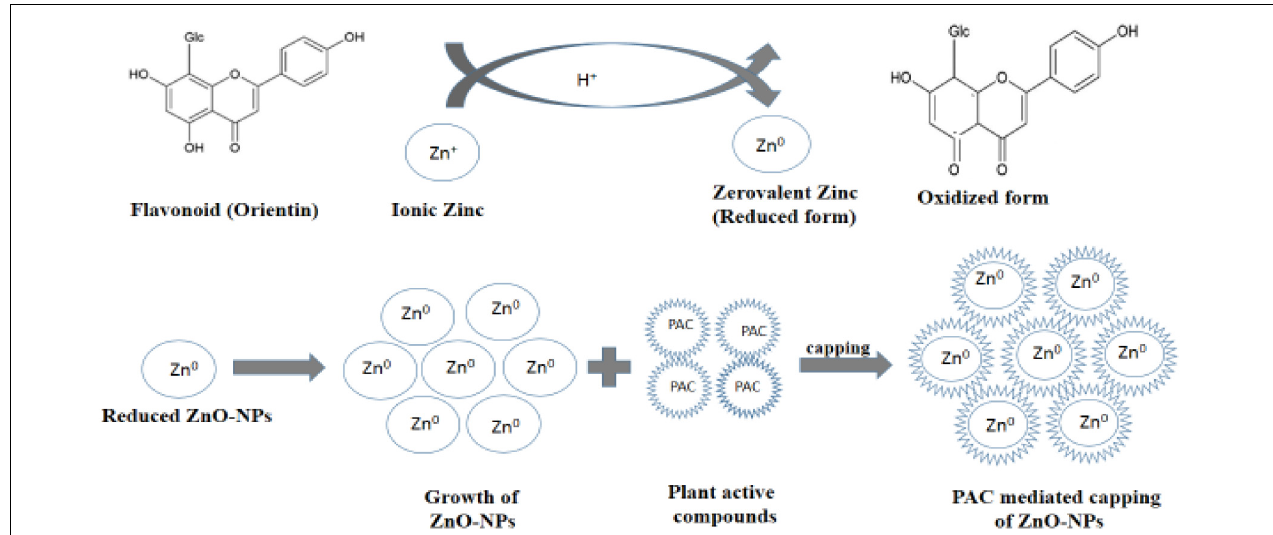
FIGURE 2 | Mechanistic approach for the synthesis of ZnO-NPs through plant active compounds.